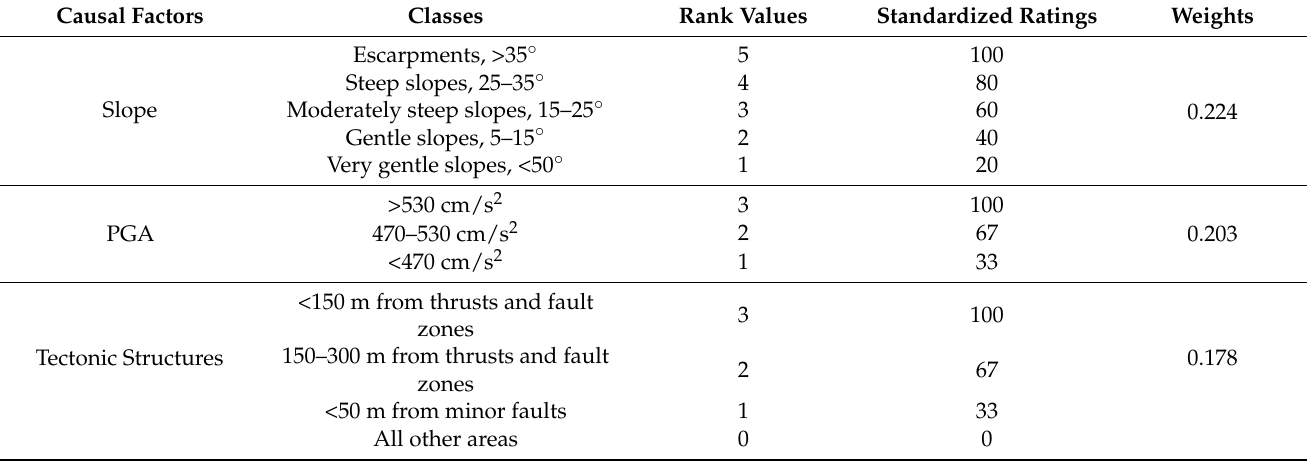
Table 4. Landslide causal factors, classes, rank values, standardized ratings and weights used in the landslide susceptibility assessment in